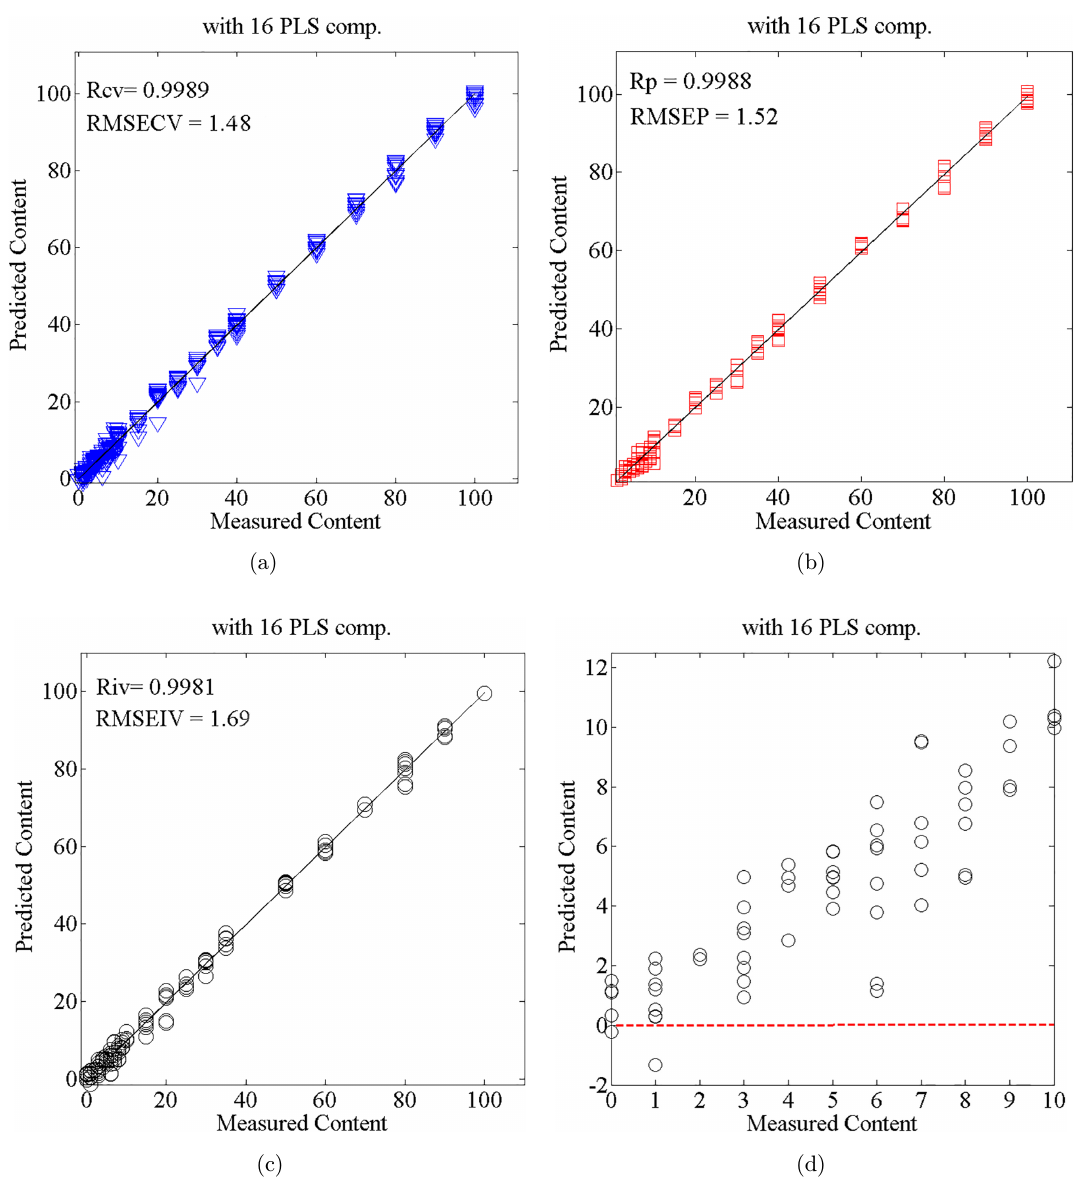
Fig. 4. The scatter plot of the generic PLS model: (a) scatter plot of calibration set, (b) scatter plot of prediction set, (c)scatter plot of independent valiation set, and (d) scatter plot of adulterated camellia oil samples with volume proportions ranged from 0 to 10%V/V in independent validation